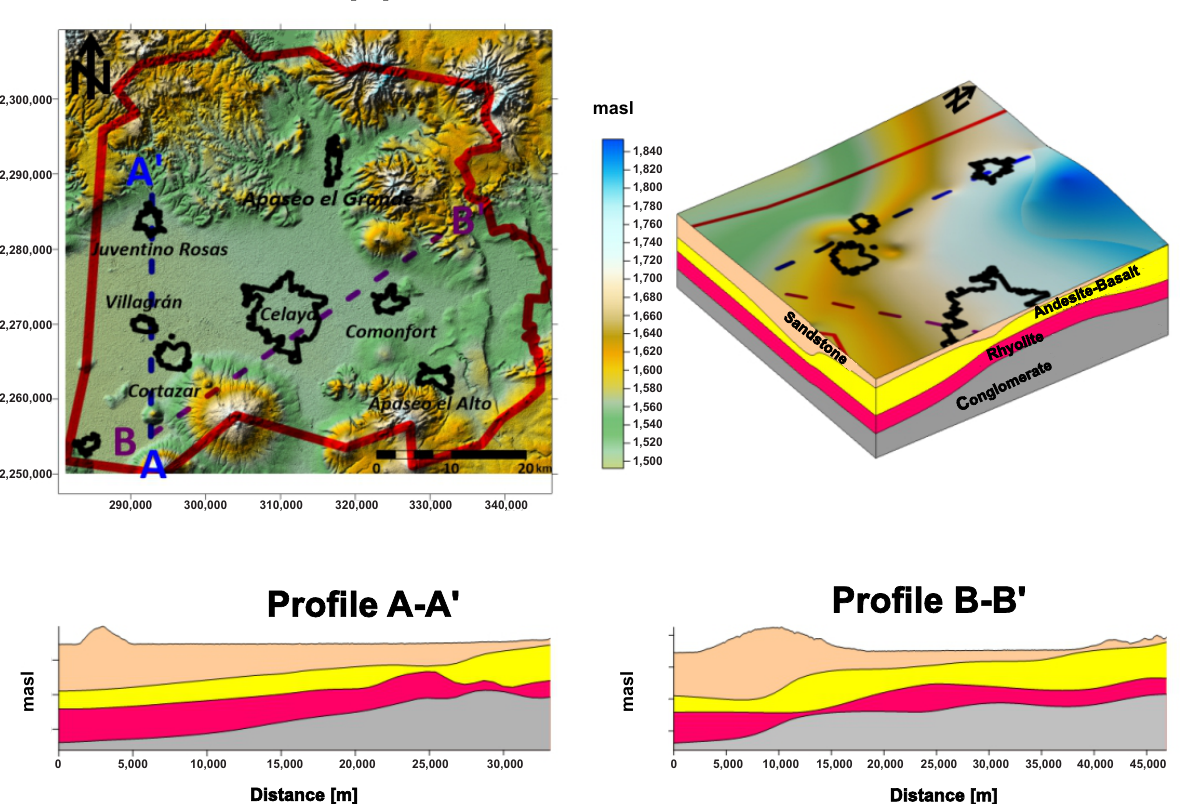
Figure 3. Hydrogeological model of the CV aquifer, Profile A-A’ corresponds to a geological section from South to North and Profile B-B’ corresponds to a geological section from West to